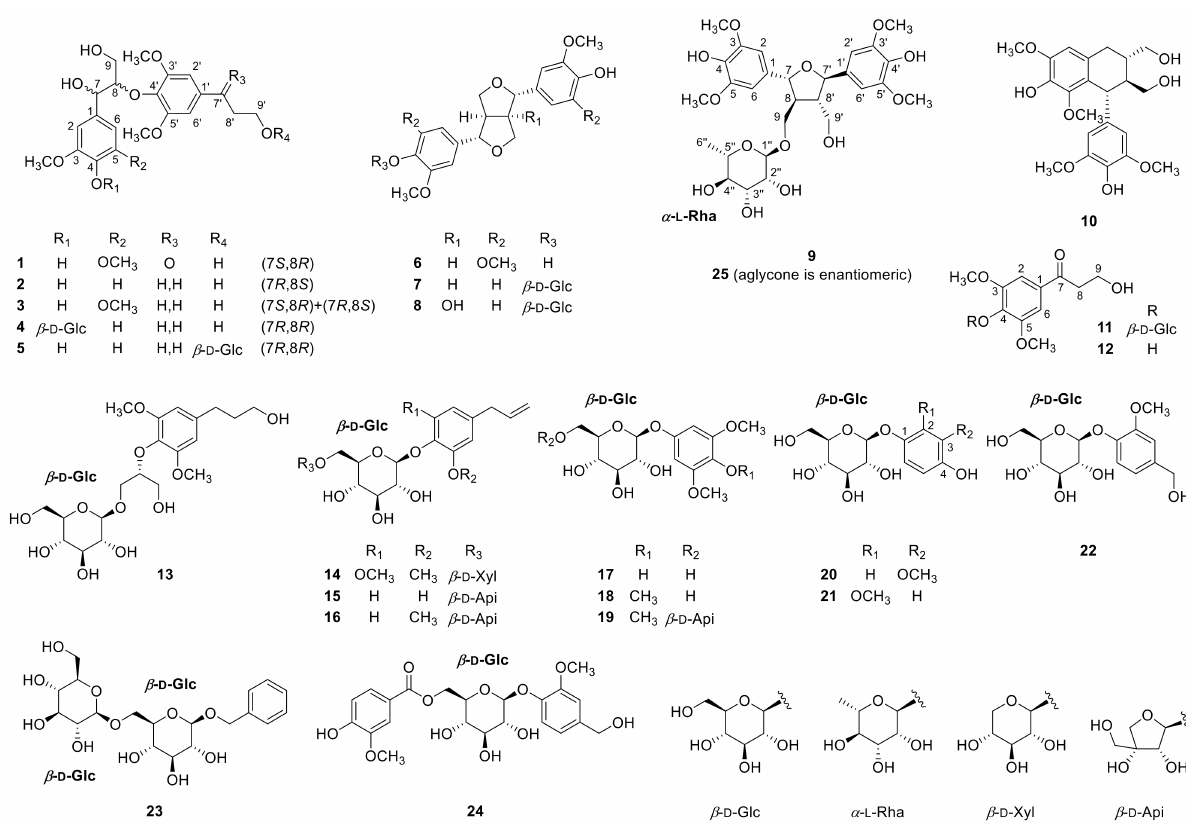
Figure 1. Chemical structure of compounds 1 – 25